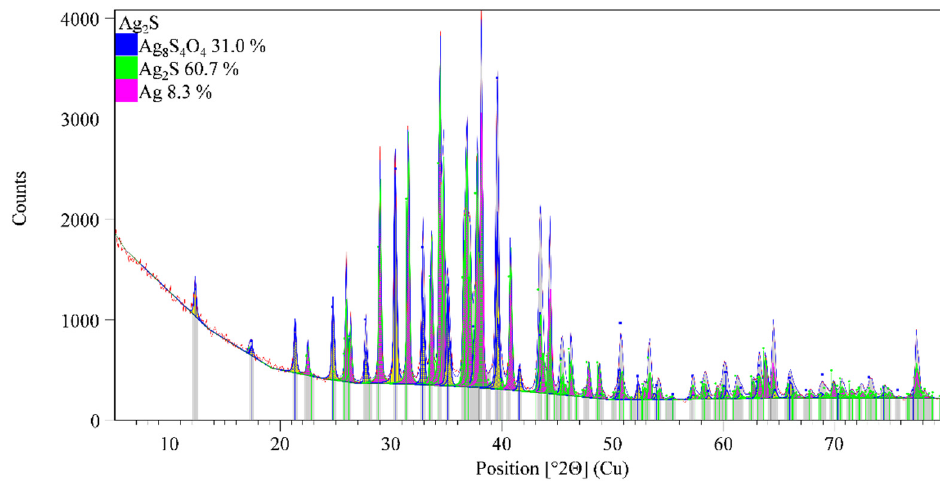
Figure 5. XRD pattern of silver sulfide.